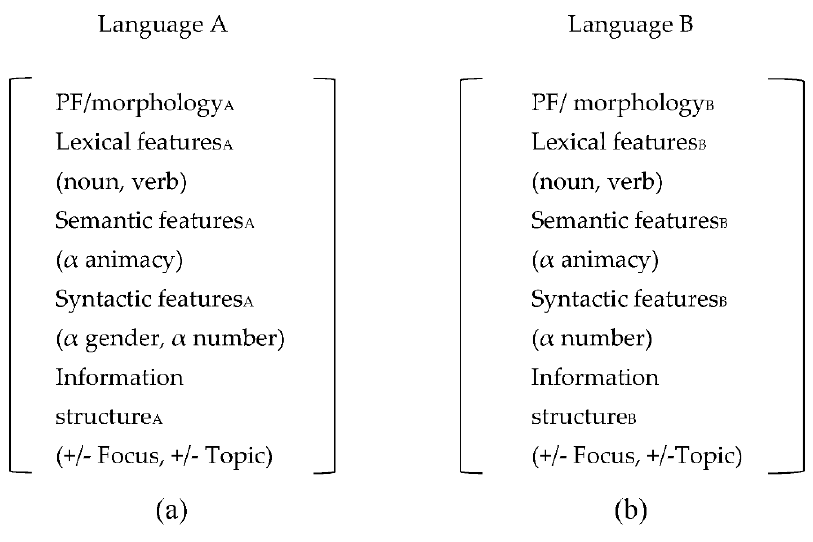
Figure 2. ( a ) Alignment in Language A; ( b ) alignment in Language B.